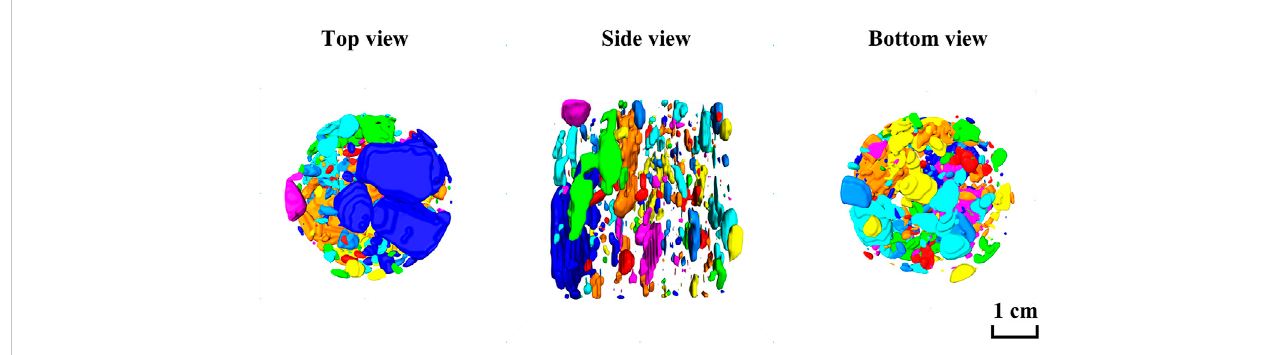
FIGURE 11 The clay particle distribution of CPS in 3D view.